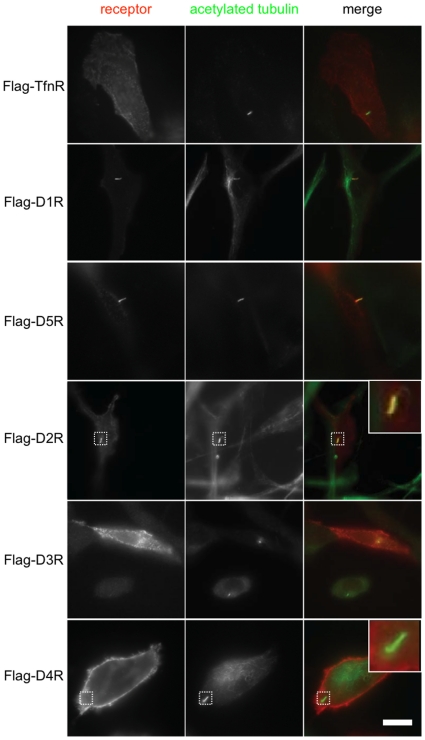
Subtype-specific localization of dopamine receptors to the primary cilium.NIH3T3 cells were transfected with expression construct encoding the indicated Flag-tagged dopamine receptor or transferrin receptor. 48 hours after transfection, cells were fixed and receptors present in the plasma membrane were selectively labeled by incubating non-permeabilized cells in the presence of anti-Flag antibody, and cells were then permeabilized to immunolabel acetylated tubulin. Each row of images shows representative cells expressing the indicated Flag-tagged receptor construct. The merged image in each row shows surface receptor immunoreactivity in red and acetylated tubulin in green to mark the primary cilium. Insets show the indicated region at higher magnification, scale bar corresponds to 10 µm.